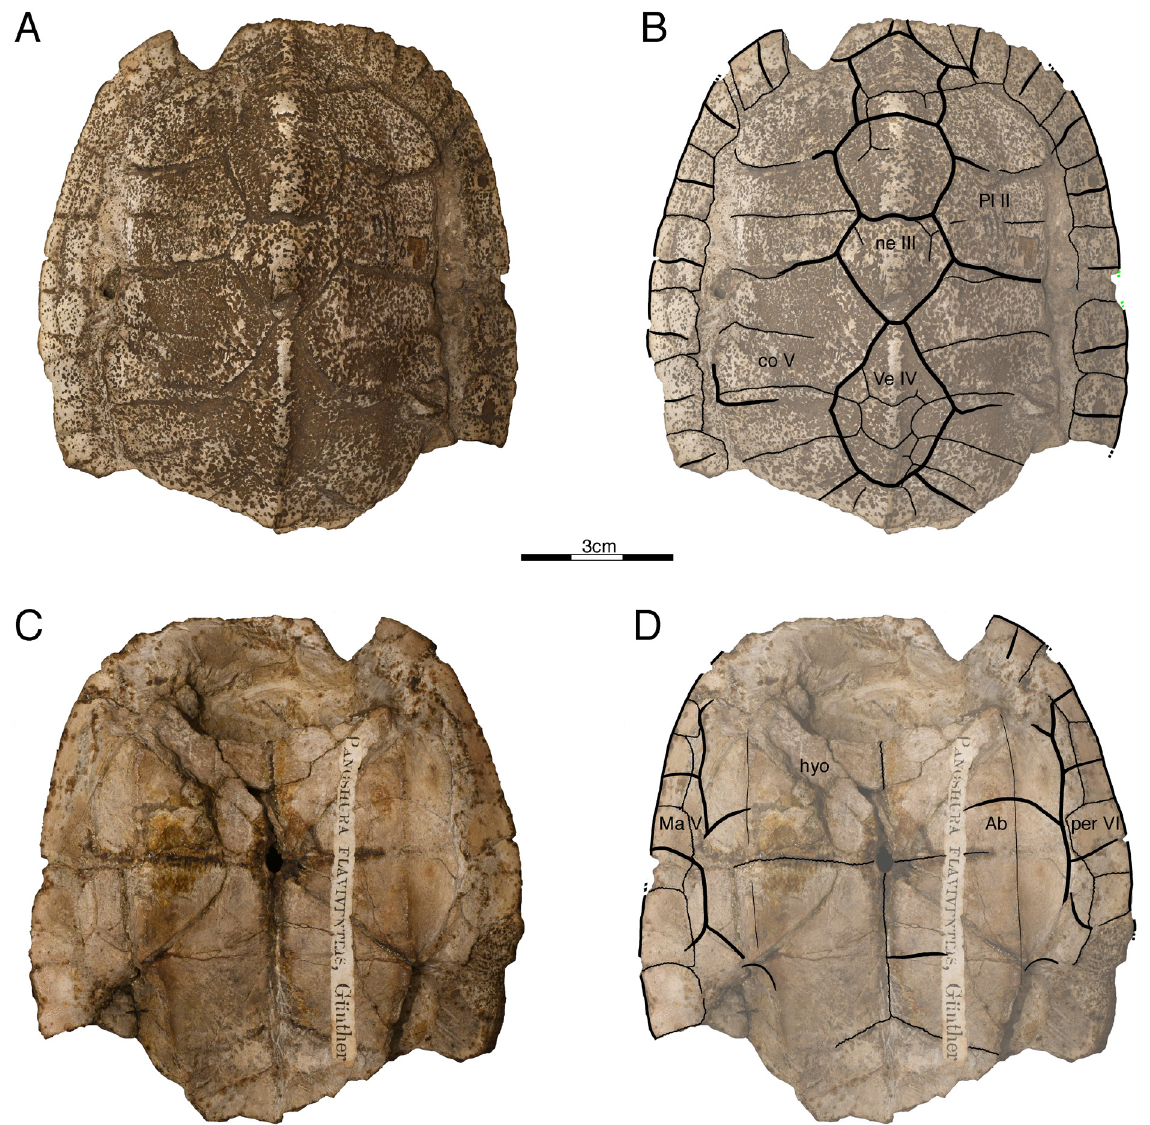
Fig. 18. IM E.110, referred to Pangshura flaviventer Günther, 1864 by Lydekker (1885a), here identified as Pangshura sp. A . Photograph of carapace. B . Illustration of carapace. C . Photograph of plastron. D . Illustration of plastron. Scale bar: 3